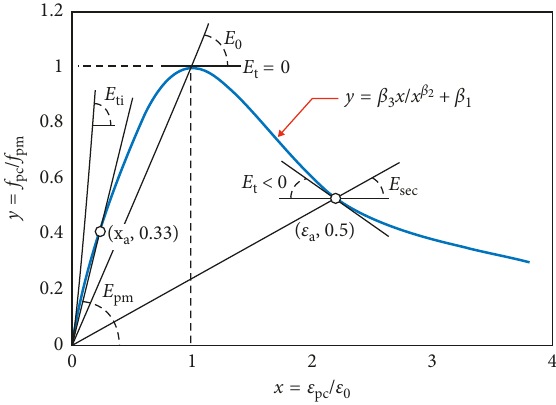
Figure 11: Generalized compressive stress-strain